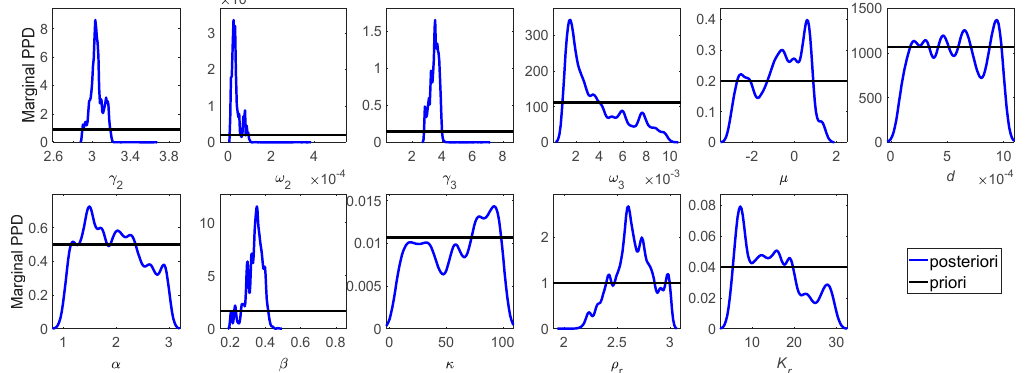
Figure 4. Estimates of one-dimensional marginal posterior probability distributions (PPDs) for fluid model parameters.